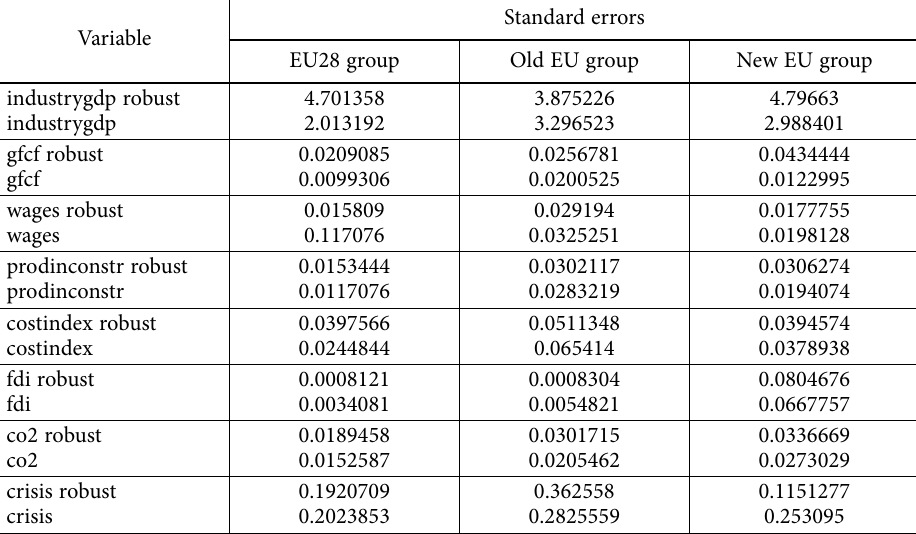
Table 4. Differences between the standard errors (source: Stata, Authors’ calculation)